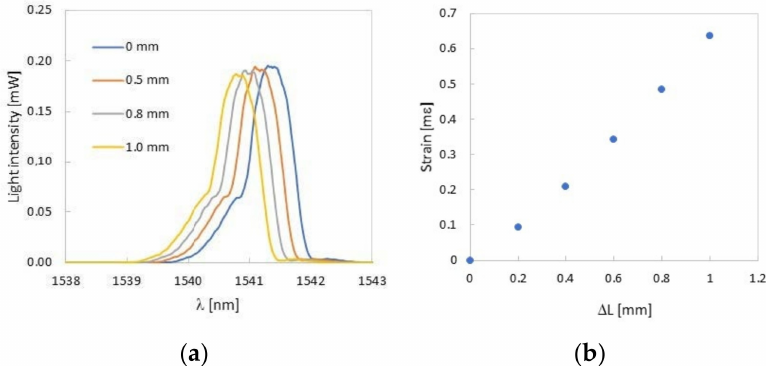
Figure 10. Change of the Bragg wavelength as a function of ∆ L ( a ) and determination of strain (modulus) sensitivity ( b ) for a replaceable measuring head with a thickness of 1.5 mm placed in the compliant mechanism.